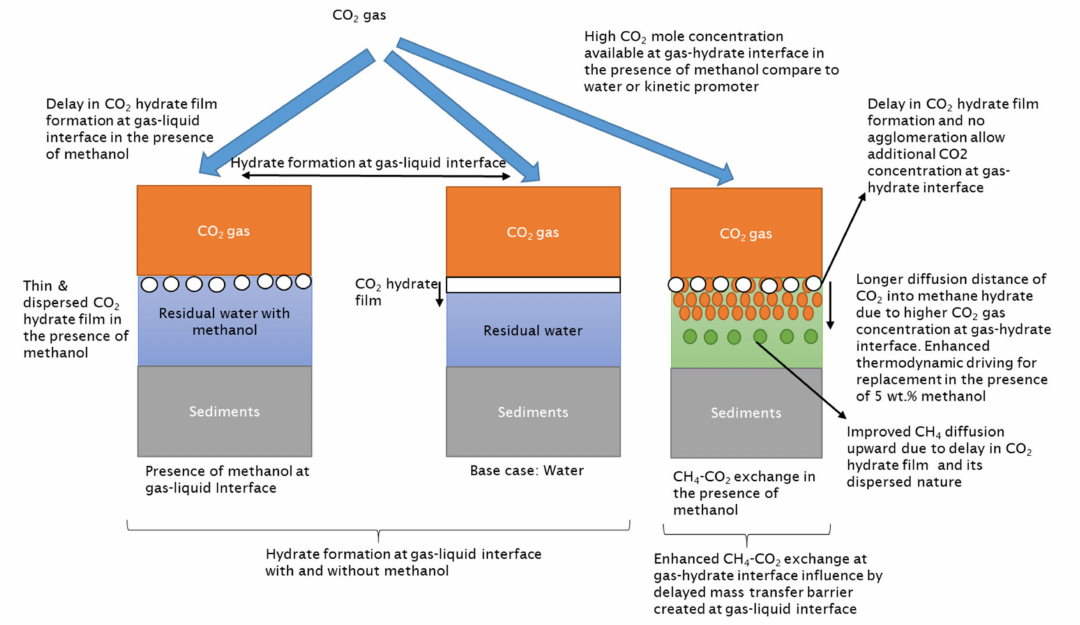
Figure 12. CH 4 -CO 2 exchange mechanism in the presence of MeOH in water. MeOH enhances CH 4 replacement and improves CO 2 storage due to enhanced thermodynamics of CH 4 -CO 2 exchange and delay in CO 2 hydrate film formation at gas–liquid